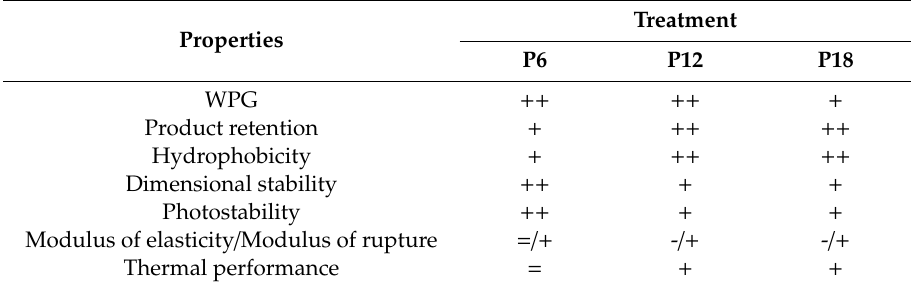
Table 6. Summary table of all tests and results compared to radiata